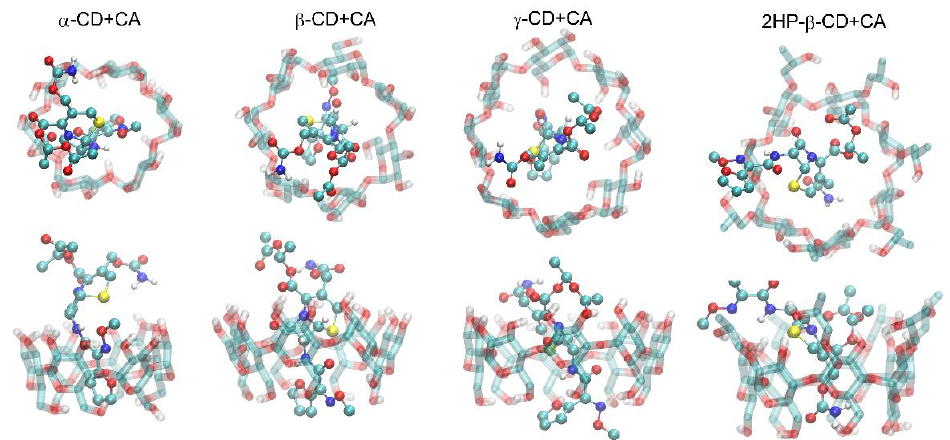
Figure 10. The most favorable structures of the CA–CD complexes identified in the docking simu- lations. The rest of details as in Figure 9.